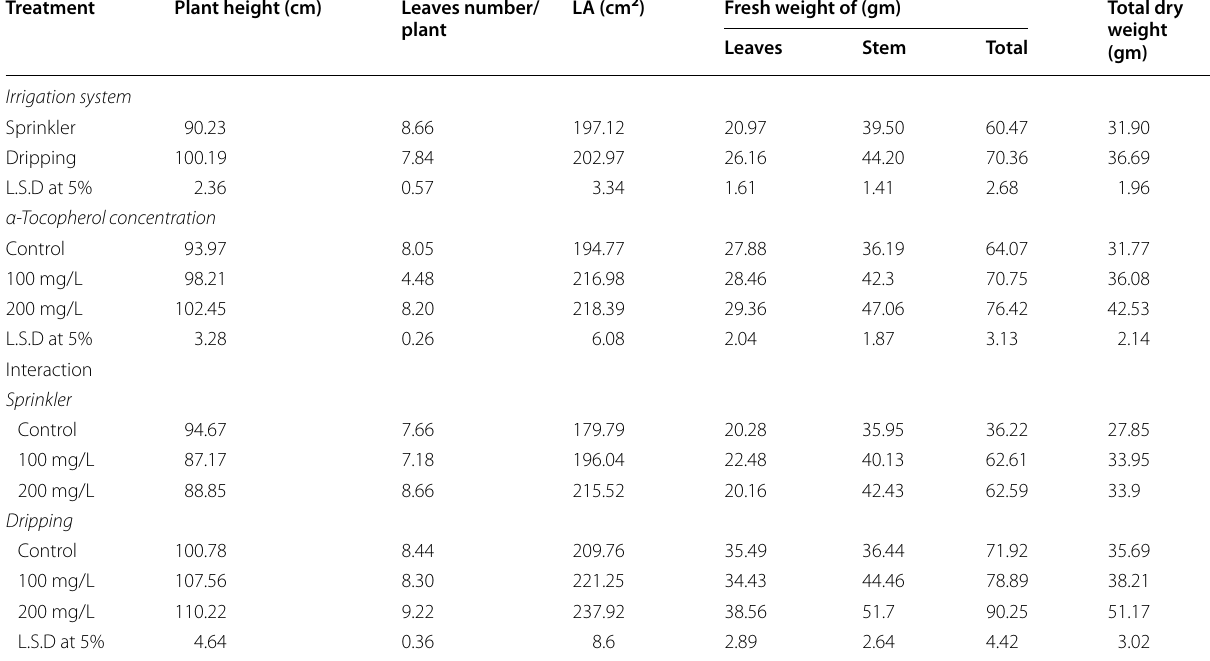
Table 2 Effect of irrigation system and α-tocopherol foliar spray on growth attributes in sweet corn plant in sandy soil conditions (combined analysis of two seasons)